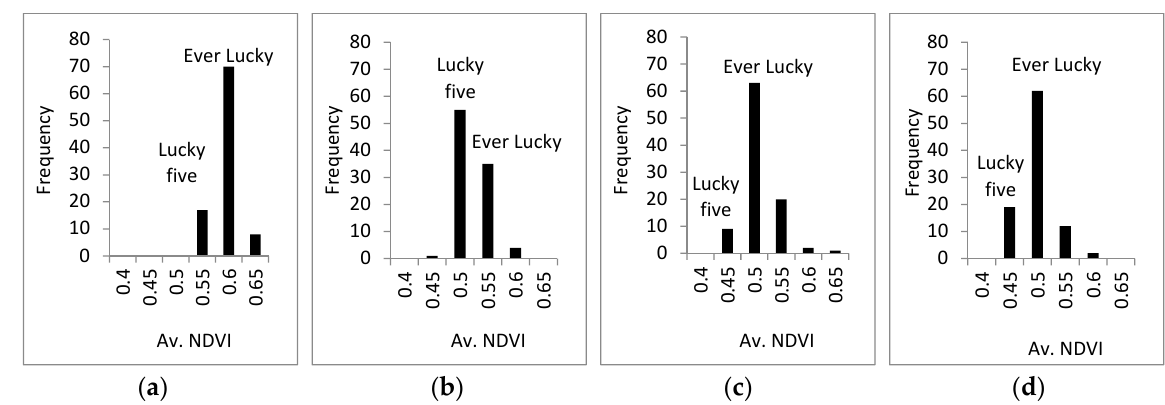
Figure 6. ( a ) Frequency distribution of average NDVI ( a ) before flooding, ( b ) during flooding, ( c ) during early recovery, and ( d ) during prolonged recovery. The commercial checks are attributed to their NDVI bin.